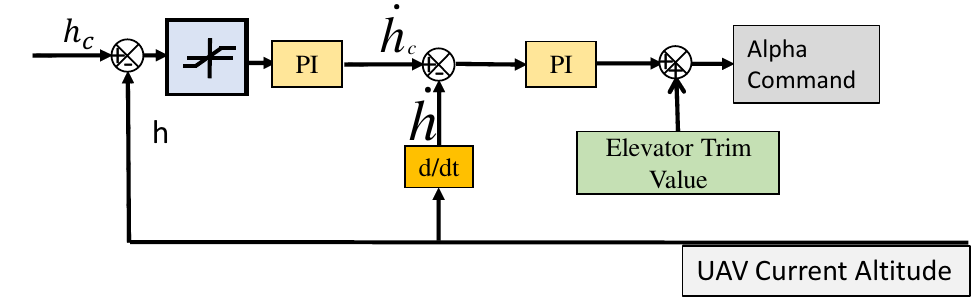
Figure 4. Altitude control loop.